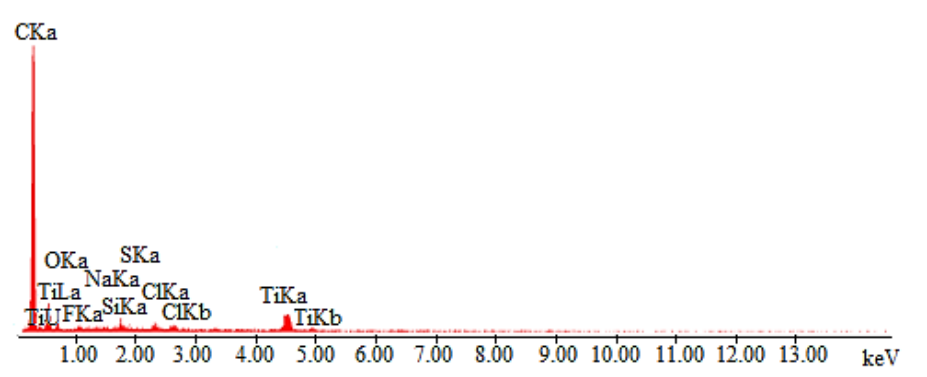
Figure 11. EDS spectrum of element distribution for Ti-Si coated NATAN fabric at point “1” (Figure 10b).